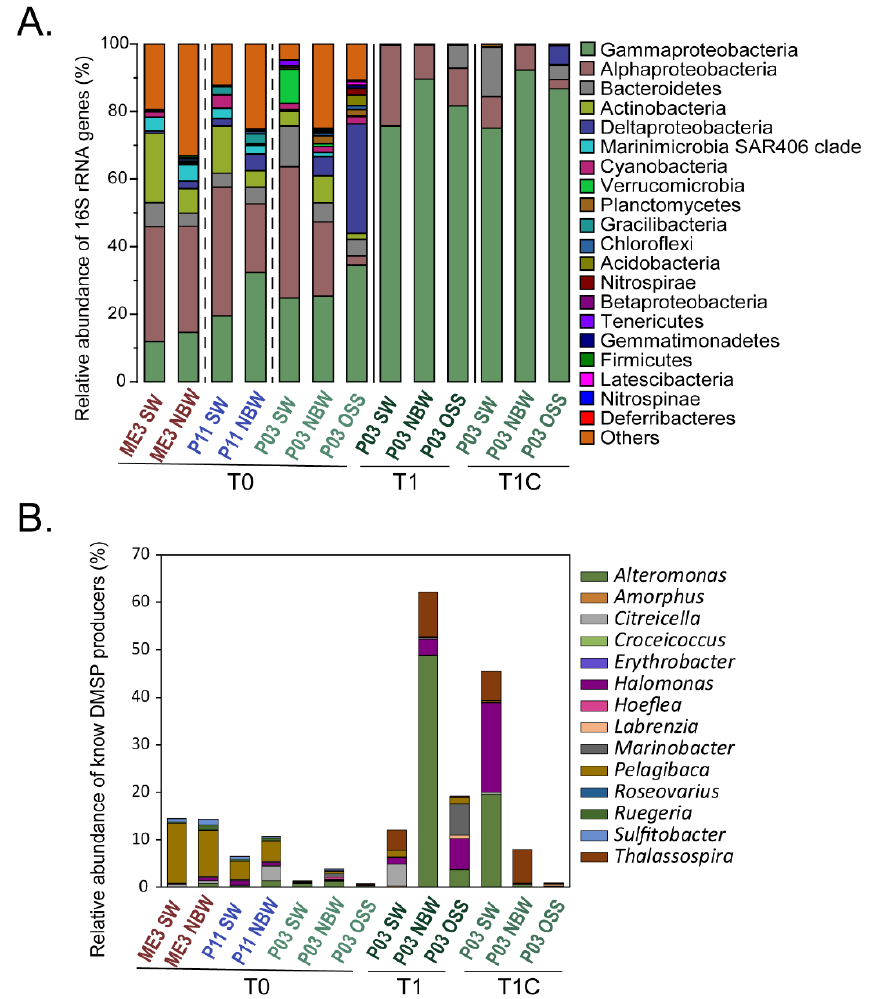
Figure 4. Bacterial community composition and known DMSP producers revealed by 16S rRNA gene amplicon sequencing. ( A ) Relative abundances of taxon-assigned sequences at phylum and class levels from all-natural samples (T0), and from control (T1C) and enriched (T1) incubation experiments of P03 after 14 days. ( B ) Relative abundances of genera with known DMSP-producing species. Data shown in ( A , B ) are the averages of three biological replicates. SW: surface water; NBW: near sea water; OSS: oxic surface sediment.